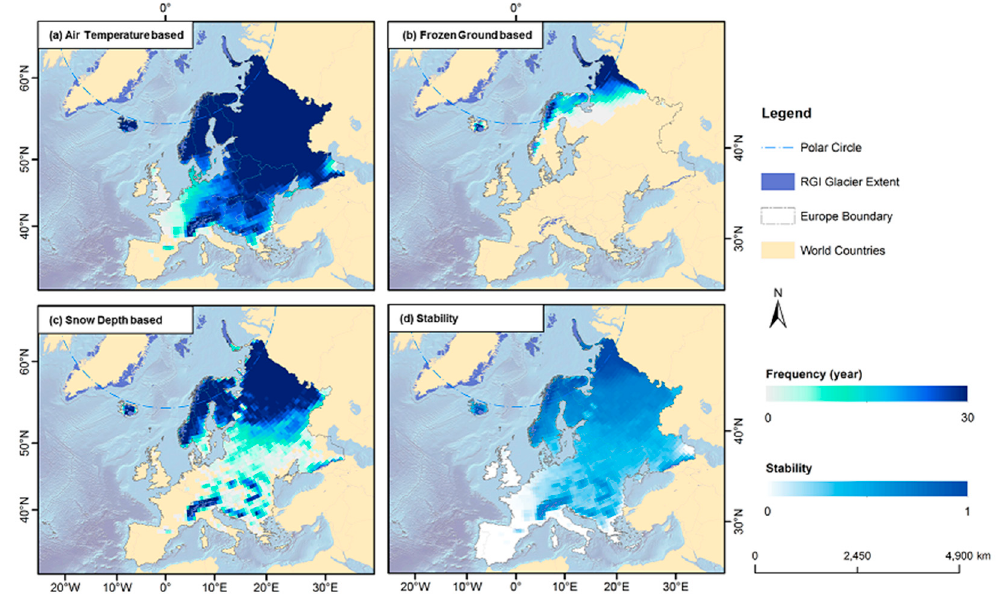
Figure 1. Cold regions in Europe delineated according to: ( a ) air temperature below 0 °C observed more than half of the time during the coldest month, ( b ) 30 cm frost penetration into the ground, ( c ) maximum snow depth on the ground no less than 30 cm, and ( d ) integrated stability parameter. RGI: The Randolph Glacier Inventory [9].